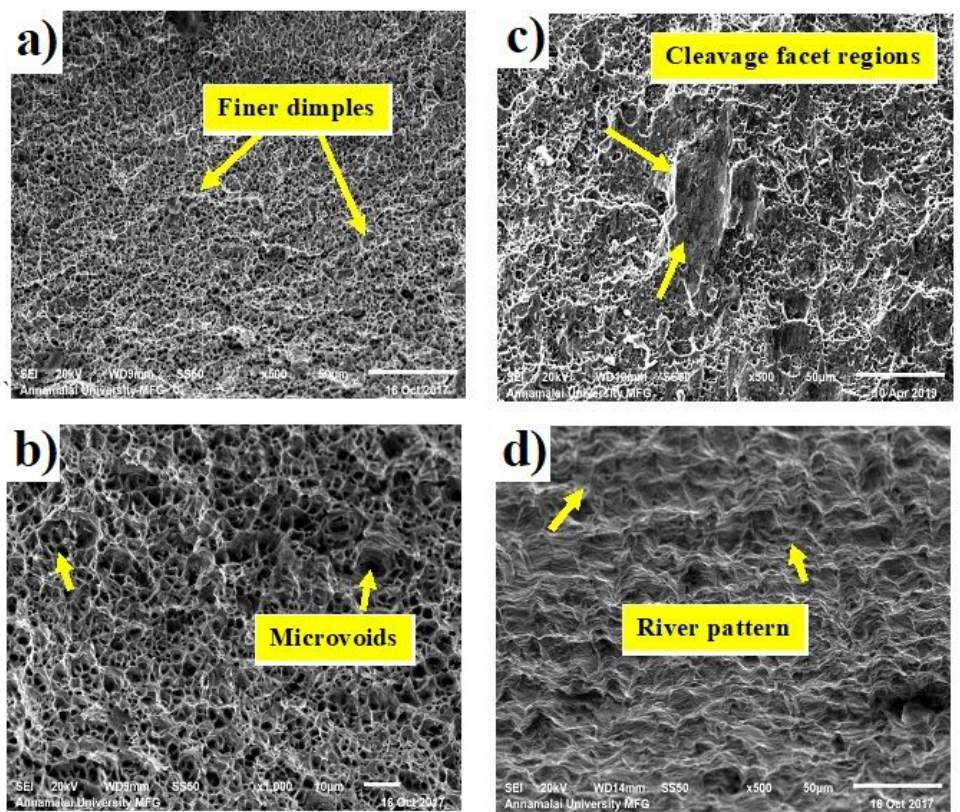
Figure 6: SEM fractograph of TSFL specimens of optimized joint at lower and higher magnification: a) and b) LAP-TSFL; c) and d) CROSS-TSFL specimen